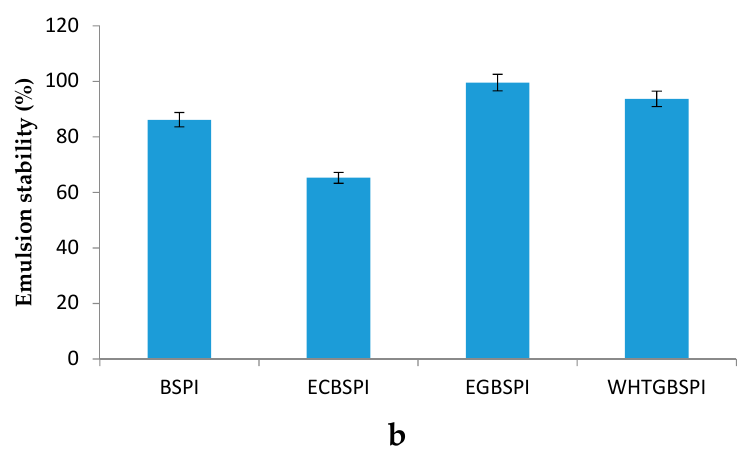
Figure 8. Emulsification ( a ) and emulsion stability ( b ) of BSPI and its modified products. Data are shown as the mean ± SD of three replicates.